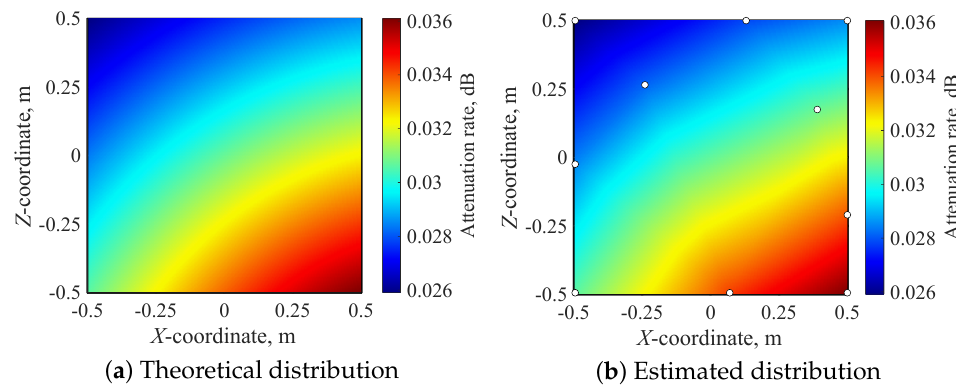
Figure 6. Distributions of attenuation rate in the sound source grid. Table 2. Computational